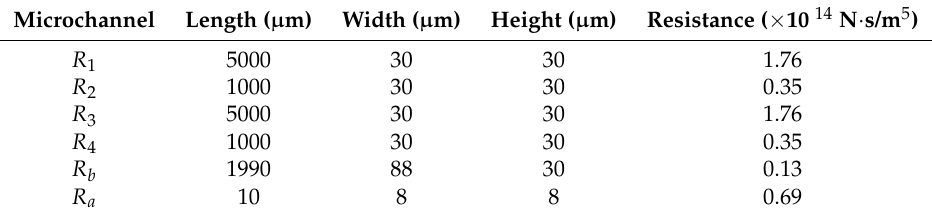
Table 1. Dimensions and resistances of microchannels in the microfluidic Wheatstone bridge. Microchannels are denoted by their flow resistances.